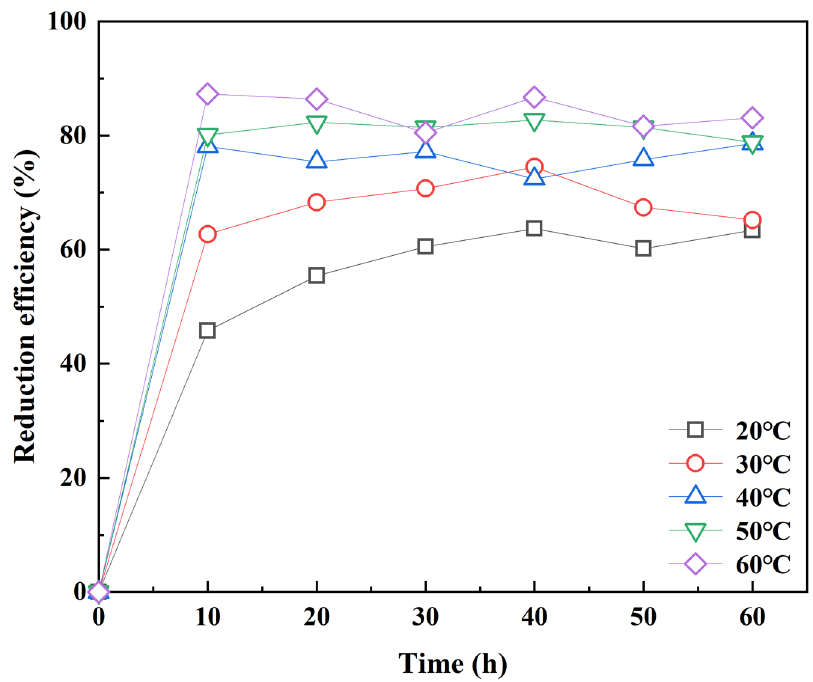
Figure 7. Effect of initial temperature on Cr(VI) reduction by RC-nZVI.